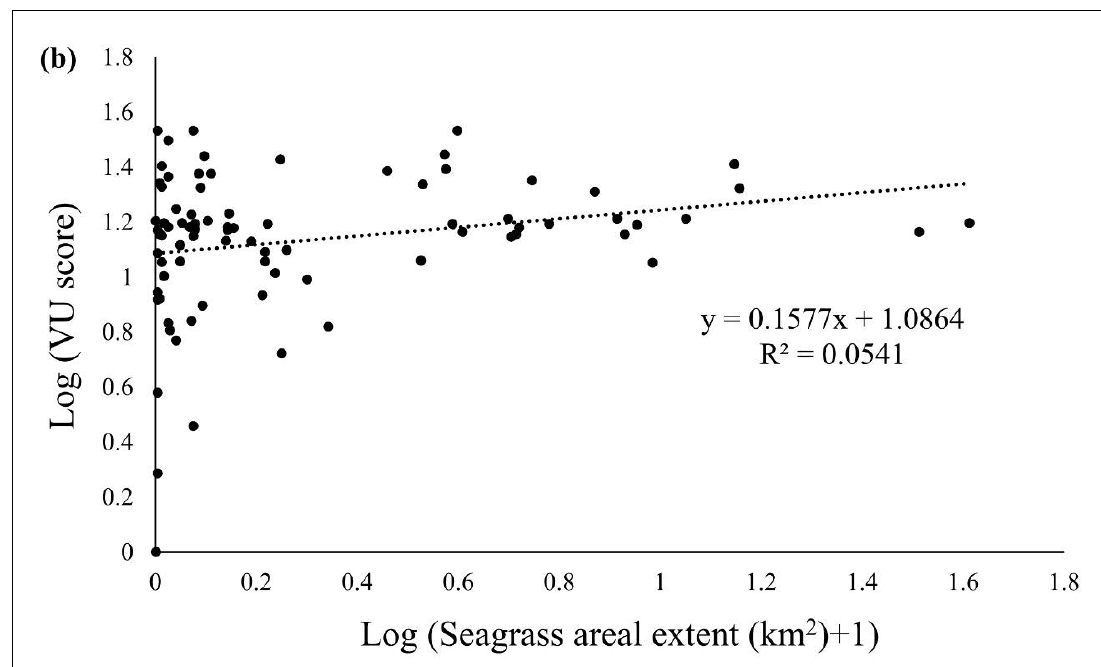
Figure 4. Relationship between seagrass-area extent (km 2 ) and ES/VU scores: ( a ) ES score and ( b ) VU score. Data were transformed using (log(x) + 1), n = 82.